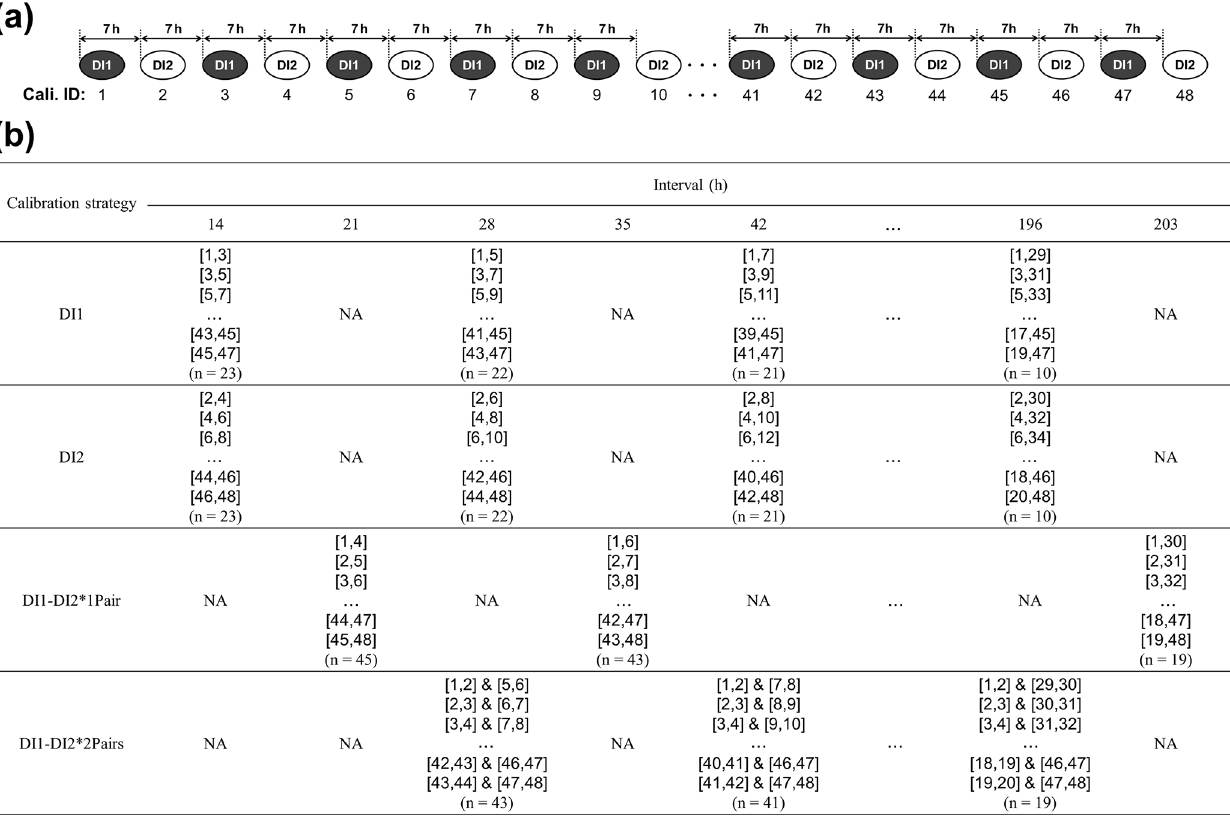
Figure 2. Overview of the four different [H 2 O] dependence calibration strategies (DI1, DI2, DI1–DI2*1Pair, DI1–2*2Pairs) for assessing [H 2 O] dependence uncertainties of the L2130i and L1102i analysers related to the length of the calibration interval. (a) The top diagram shows a part of the total 48 calibration cycles, including both the DI1 and DI2 standard waters, with a 7h interval and identity number (ID: 1– 48) as an example. (b) The bottom table presents a part of which calibration cycles the four calibration strategies utilize for obtaining [H 2 O] dependence calibration fittings at different intervals as an example. The respective DI1 and DI2 strategies used a pair of only DI1 calibration cycles and a pair of only DI2 calibration cycles for obtaining calibration fittings of [H 2 O] dependence at intervals from 14 to 196h. For example, the DI1 calibration strategy at a 14h interval with ID-[1,3] used data sets from a pair of DI1 calibration cycles (ID-1 and ID-3) to obtain [H 2 O] dependence calibration fittings. The DI1–DI2*1Pair and DI1–2*2Pairs strategies used a pair of DI1 and DI2 calibration cycles, and two pairs of DI1 and DI2 calibration cycles, respectively, for obtaining calibration fittings of [H 2 O] dependence at intervals from 21 to 203h (DI1–DI2*1Pair strategy) or from 28 to 196h (DI1–DI2*2Pairs strategy). At each interval, the respective calibration strategy made all the pairs of each set calibration cycles (e.g. 43 two pairs at a 28h interval for the DI1–DI2*2Pairs strategy) and then obtained calibration fittings from each pair of calibration cycles. For instance, as the DI1–DI2*2Pairs strategy utilized four two-dimensional (2D) fitting methods and one three-dimensional (3D) fitting method (i.e. linear, quadratic, cubic, quartic, and linear surface fitting methods) (see Sect. 2.3), the DI1–DI2*2Pairs strategy at a 28h interval obtained 215 calibration fittings in total (i.e. 5 fitting methods × 43 two pairs) for the respective δ 18 O and δ 2 H accuracy. The procedure for assessing uncertainties in the obtained [H 2 O] dependence calibration fittings is described in Sect.